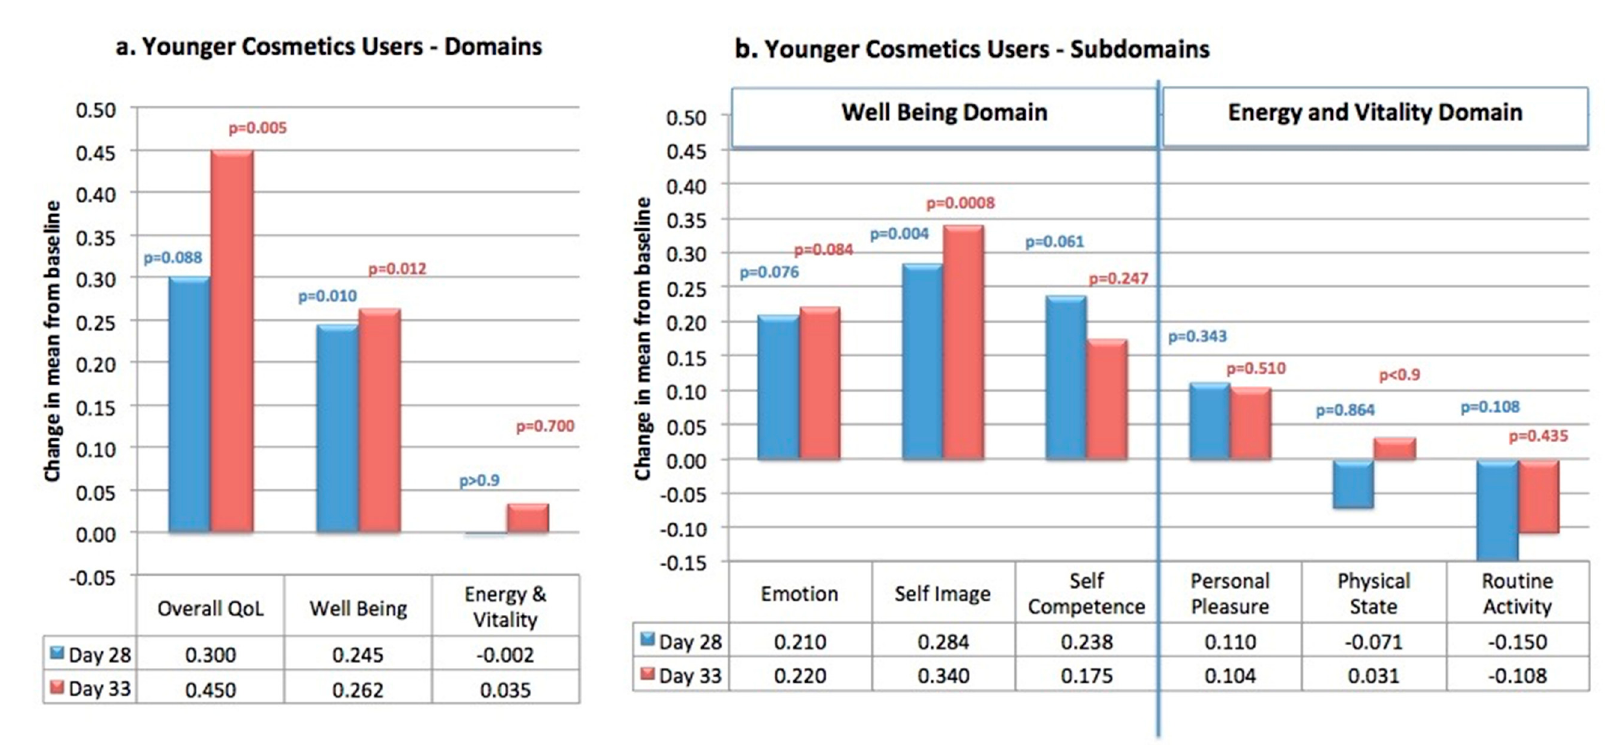
Figure 4. In a study of three parts, skin care regimen participants were asked to fill out the FQoL ™ instrument before and after a 4-week usage period (day 28), and after 5-days of product deprivation (day 33). Mean scores for domains ( a ) and subdomains ( b ) were compared to the baseline means for significant changes. Results for the 40 participants in the cohort are presented.